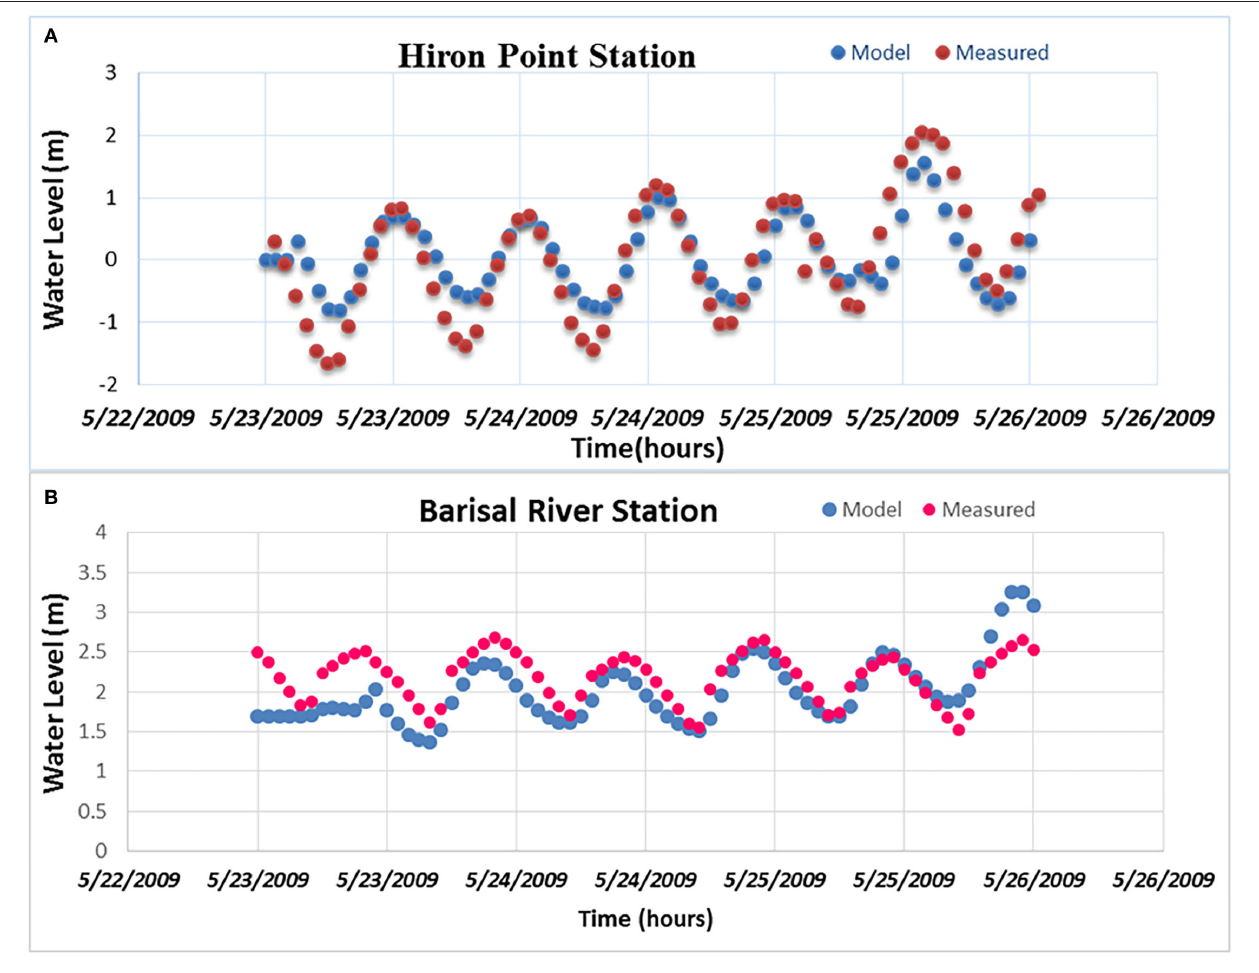
FIGURE 8 | Model validation (comparison between modeled and hourly observed data) for cyclone Aila at the Hiron Point (A) and Barisal River (B) stations.